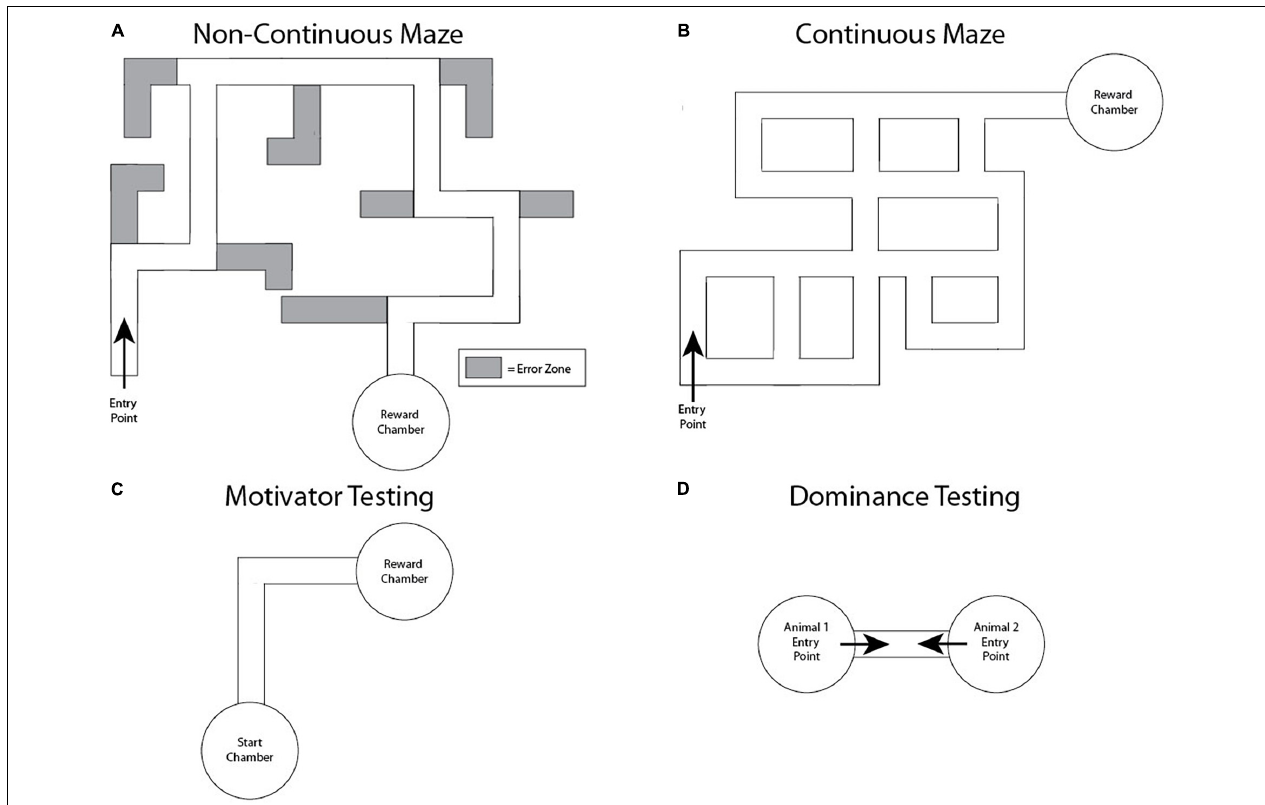
FIGURE 1 | Naked mole-rat behavioral testing configurations. (A) Modified Hebb-Williams maze with a non-continuous maze design that included dead ends. Gray regions indicate areas where an error was recorded upon entry. (B) Modified Hebb-Williams maze with a continuous design lacking dead ends and sharing more similarities with the extensive, interconnected underground tunnel systems of the naked mole-rat’s habitat. (C) Motivator testing setup. Animals were placed in the start chamber and allowed 2 min to freely explore. Animal performance was tested using a range of motivators in the reward chamber and compared to performance when that chamber was empty. (D) Dominance testing setup. Animals were placed at the indicated entry points of each chamber, facing toward one another, and analyzed for how many times one passed over the other through the tubing across three